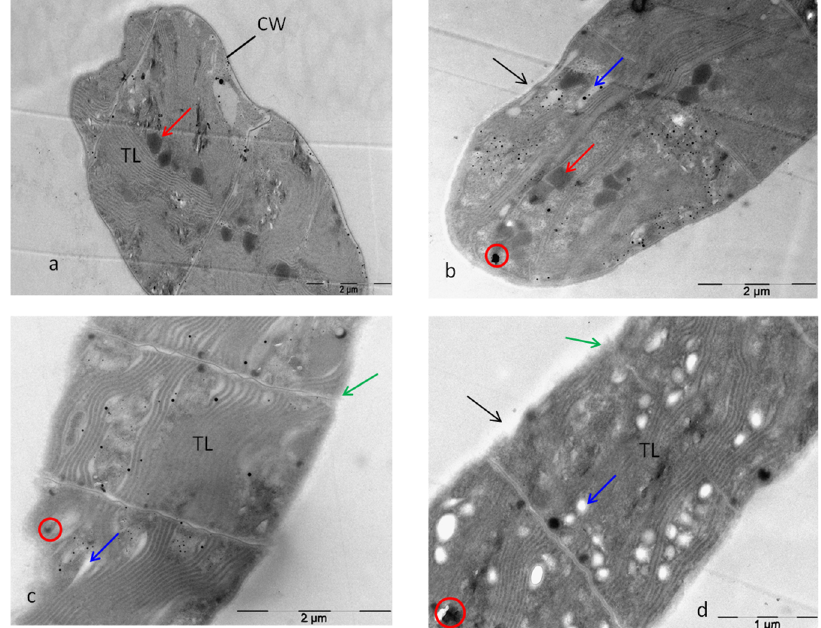
Figure 7. Transmission electron microscopy images of Spirulina platensis ( a ) control, ( b ) exposed to 0.05 µ M AgNPs, ( c ) exposed to 0.05 µ M AuNPs, and ( d ) exposed to 0.5 µ M AgNPs (red arrows indicate carboxysomes; blue–vacuolated space, green–membrane rupture, TL–thylakoids, CW–cell wall, red circles–accumulated nanoparticles).